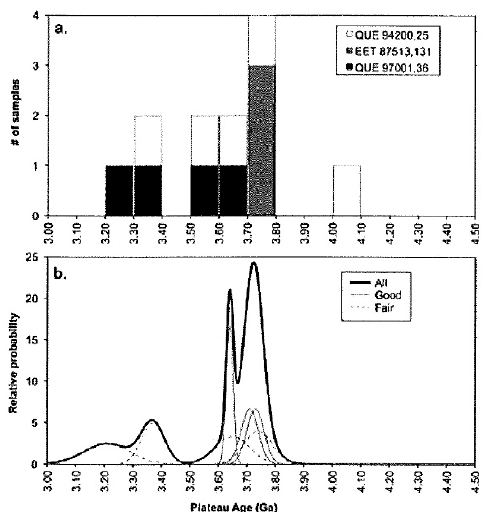
Figure 12. Age distribution of 12 impact melt clasts in H chondrite meteorites, believed to come originally from asteroid Vesta. The data show no measured ages between 3.8 and 4.0 Ga ago, the date for the “classic” terminal cataclysm. Lower figure shows ideogram for data judged “good” or “fair.” Note that time flows from right to left, contrary to most of our diagrams. (Cohen 2013 [117]).